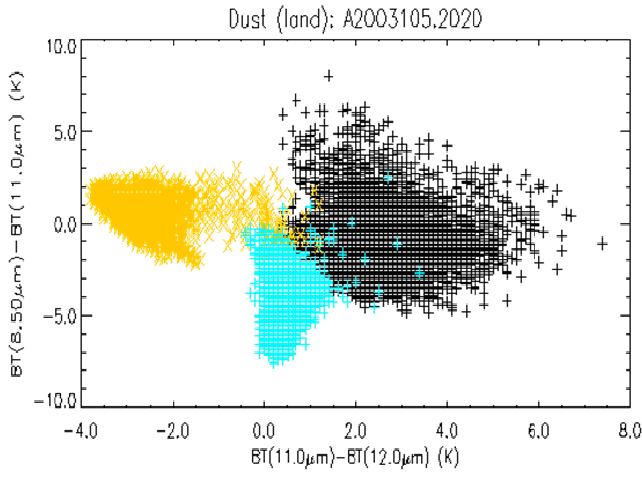
Figure 4. Scatter plot of the brightness temperature difference between MODIS 8.5 and 11.0 µm versus that between MODIS 11.0 and 12.0  m for dust (yellow x’s), clear-sky (light-blue crosses), and cloud (black crosses) pixels in Figure 1.